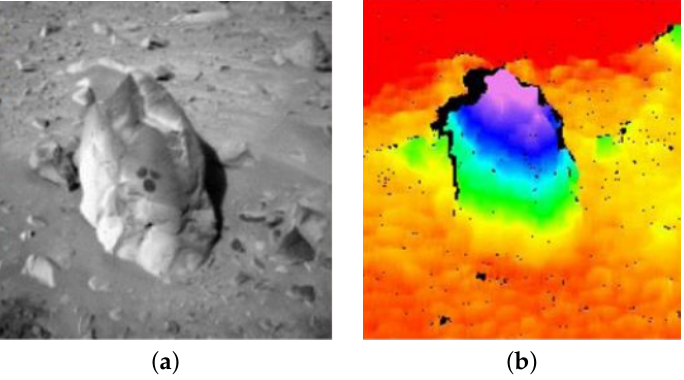
Figure 1. JPL stereo vision image processing on board MER rovers. ( a ) is from the stereo pair, while ( b ) is the elevation map generated using stereopsis (Courtesy